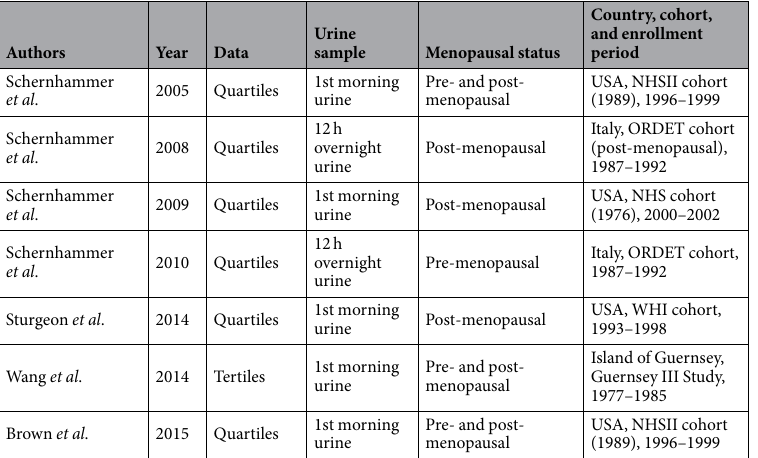
Table 1. Characteristics of the included studies in this meta-analysis. NHSII, Nurses’ Health Study II; NHS, Nurses’ Health Study; WHI, Women’s Health Initiative Observational; ORDET, Hormones and Diet in the Etiology of Breast Cancer Risk.